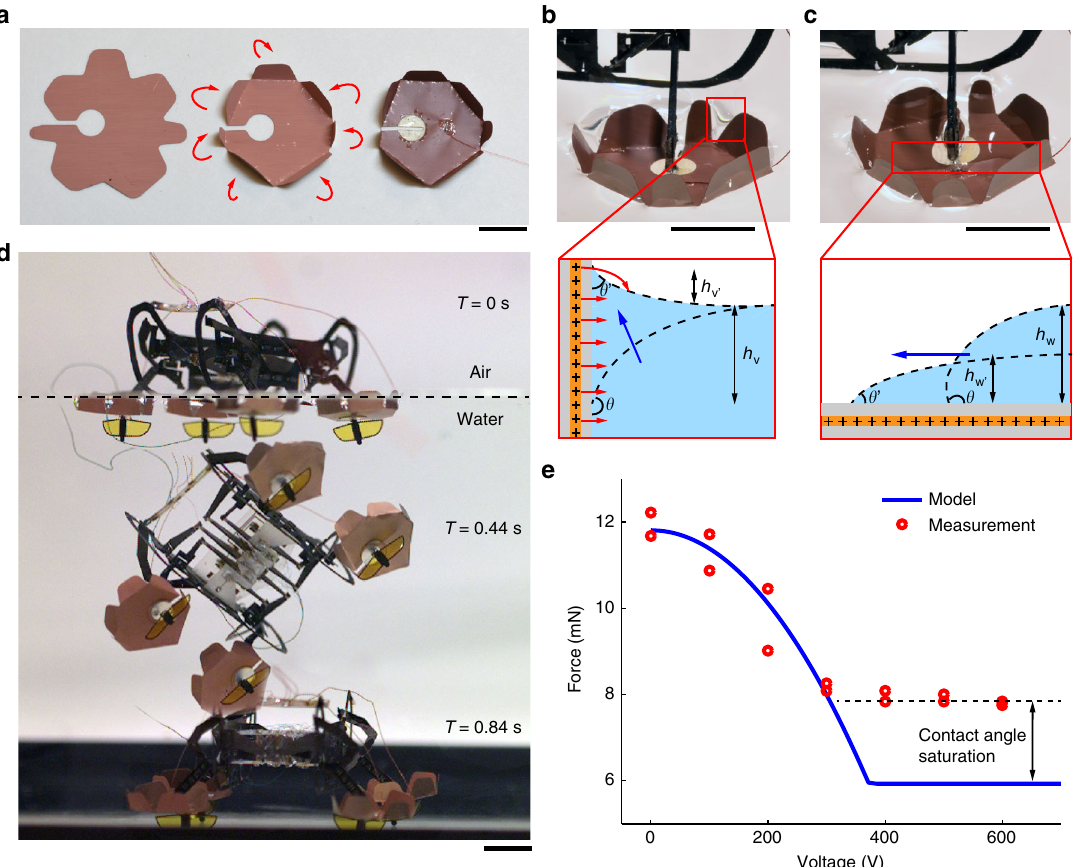
Fig. 3 Electrowetting pad and controllable transition through the air-water interface. a Fabrication of an EWP. An EWP is laser machined from a 5 µ m copper sheet, folded manually, wired, and then coated with 15 µ m Parylene. b Modi fi cation of contact angle through electrowetting. When a 600 V signal is sent to the EWP, the contact angle between the EWP ’ s vertical sides and the water surface decreases, which reduces the surface tension force. c Spontaneous wetting of the EWP ’ s charged horizontal surface. The increase of surface wettability causes water to fl ow onto the EWP ’ s upper surface, consequently sinking the robot. d Composite image of a robot sinking into water when all four EWPs are actuated with a 600V signal. Scale bars ( a – d ), 5 mm. e Experimental characterization of the maximum upward force generated by an EWP at different voltages. Due to change of contact angle and spontaneous wetting, the net upward force decreases as the input voltage